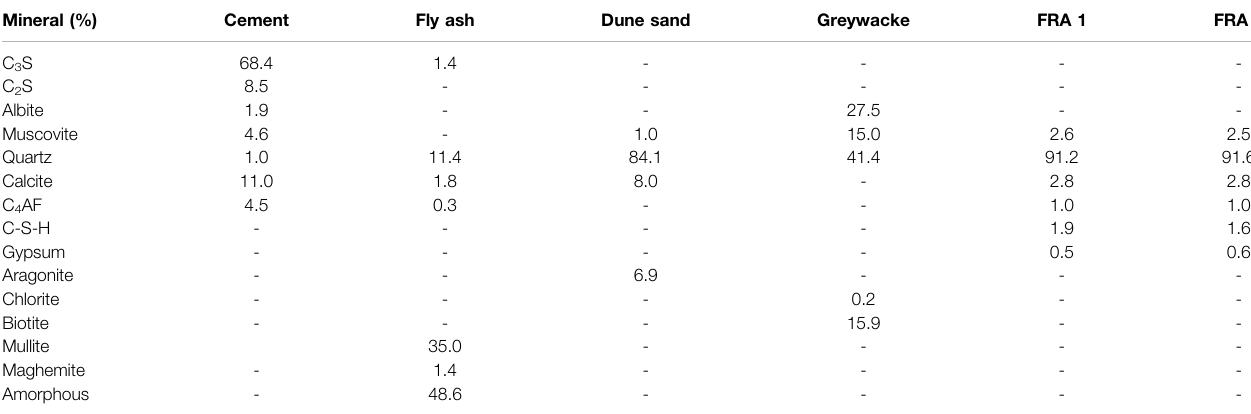
TABLE 4 | XRD mineralogical composition of materials. Mineral